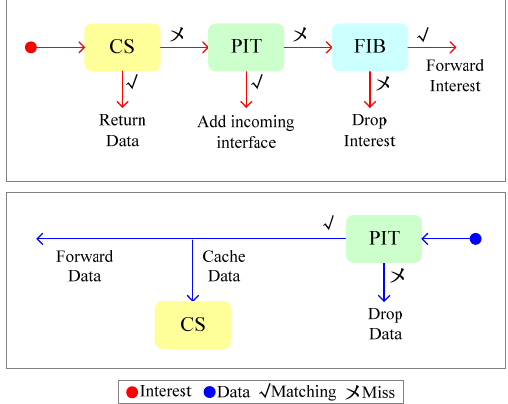
Figure 10. Forwarding process at a satellite node.